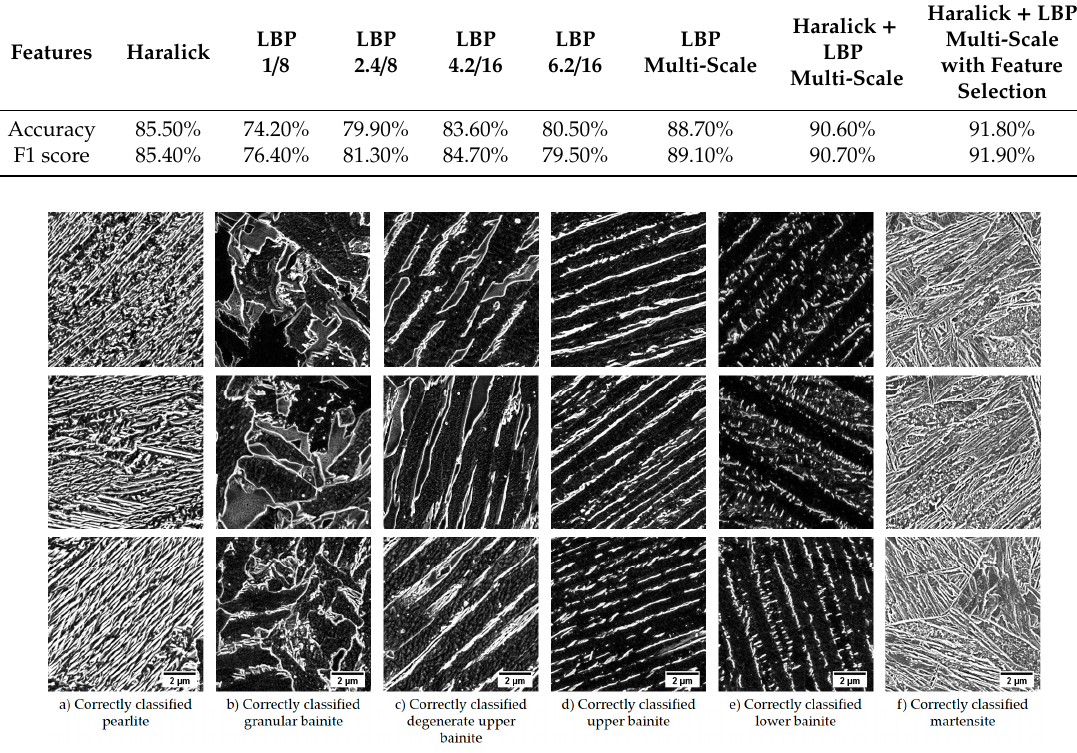
Figure 7. Examples of correctly classified images for each microstructure class.